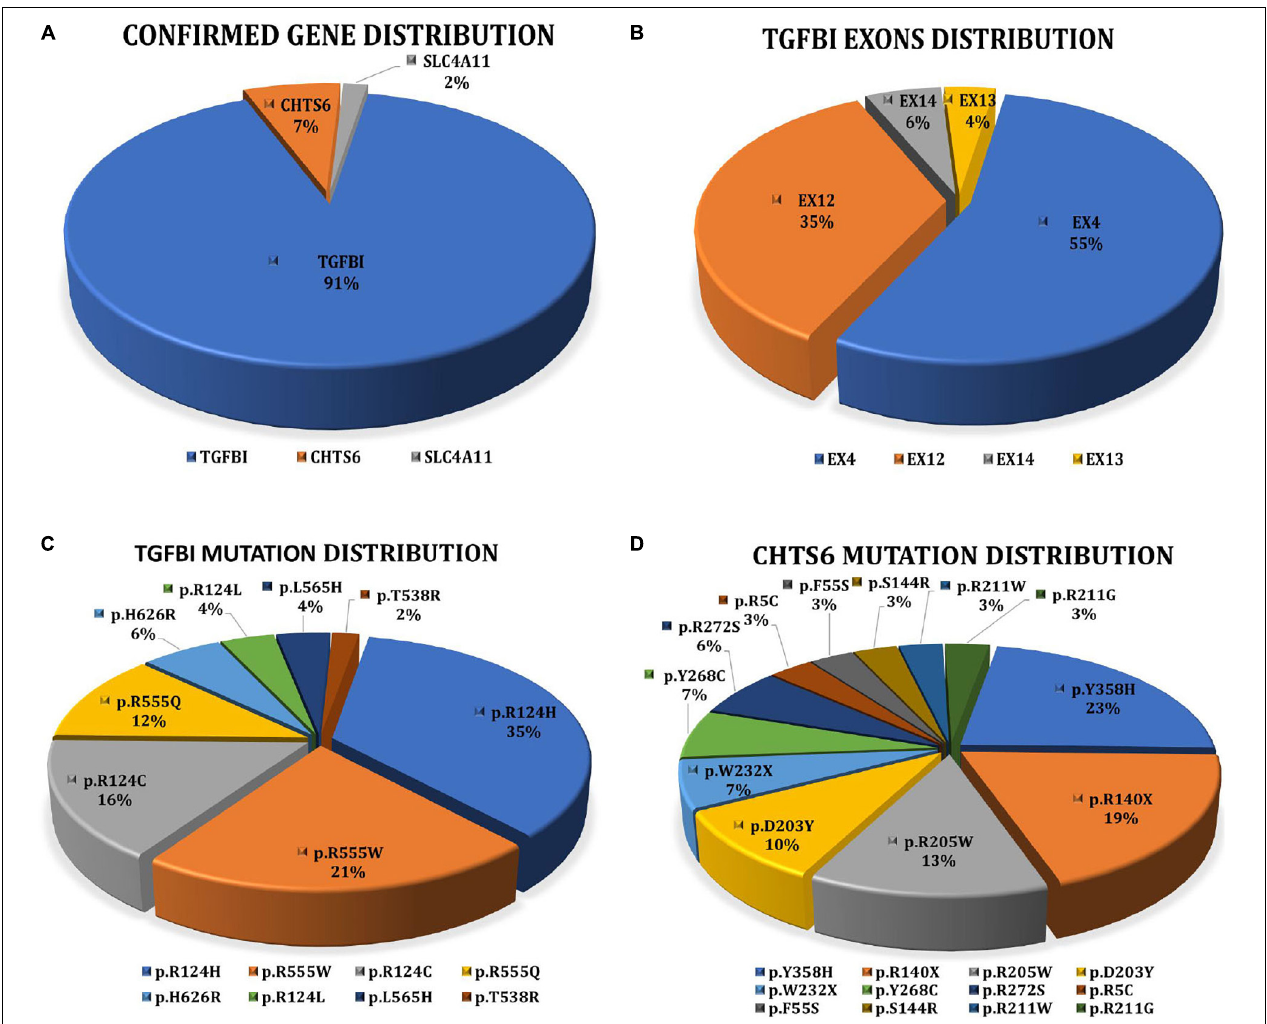
FIGURE 2 | (A) Interpretation rate of three genes detected in 56 clinically diagnosed CD patients with clear molecular diagnosis. 51 patients with TGFBI , four patients with CHST6 , and one patient with SLC4A11. (B) Distribution of TGFBI pathogenic mutations in exons. (C) Proportion of eight TGFBI distinct pathogenic mutations detected in 51 CD patients. (D) Proportion of 12 CHST6 distinct pathogenic or likely pathogenic mutations identified in four patients and 24 heterozygous